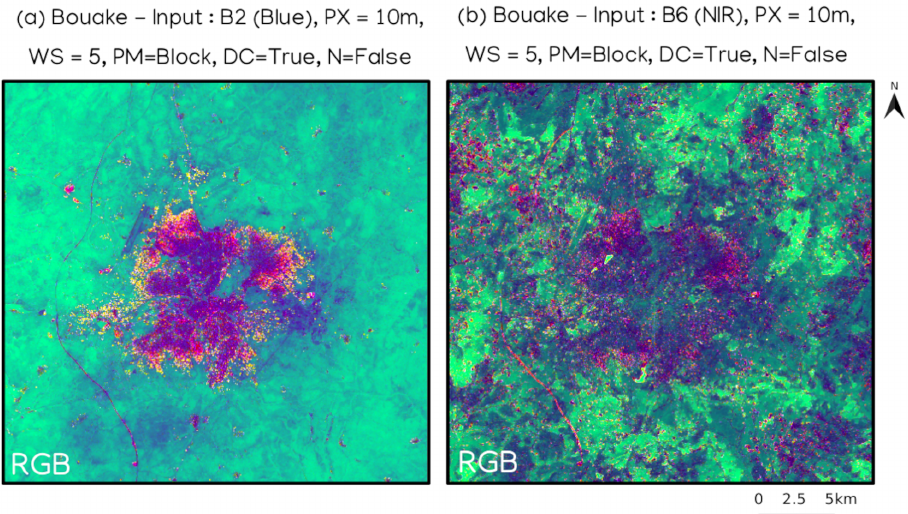
Figure 4. Influence of spectral bands used as input in the FOTOTEX algorithm for the characterization of urban areas at the macro-scale using Sentinel 2 images on Bouake. ( a ) B2 (blue) sentinel 2 band, and ( b ) B6 (NIR) Sentinel 2 band. (PX = pixel size, WS = window size, PM = partitioning method, DC = DC component, N =